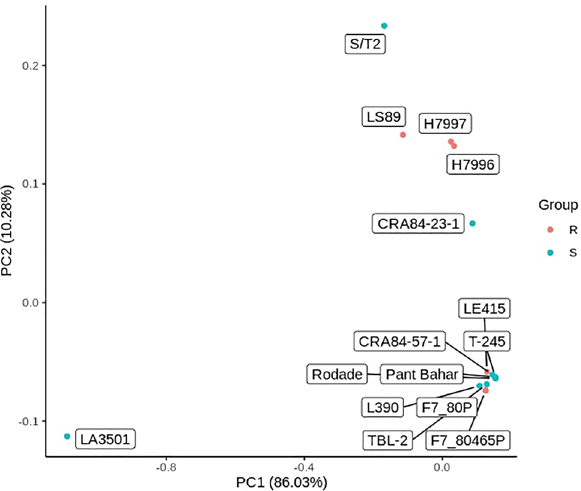
Figure 1. The Principal Coordinate Analysis based on all of the high-quality polymorphisms of the bacterial wilt ( Ralstonia sp.) resistant (R; red) and susceptible (S; blue) tomato lines. H7796 is Hawaii 7996 and H7997 is Hawaii